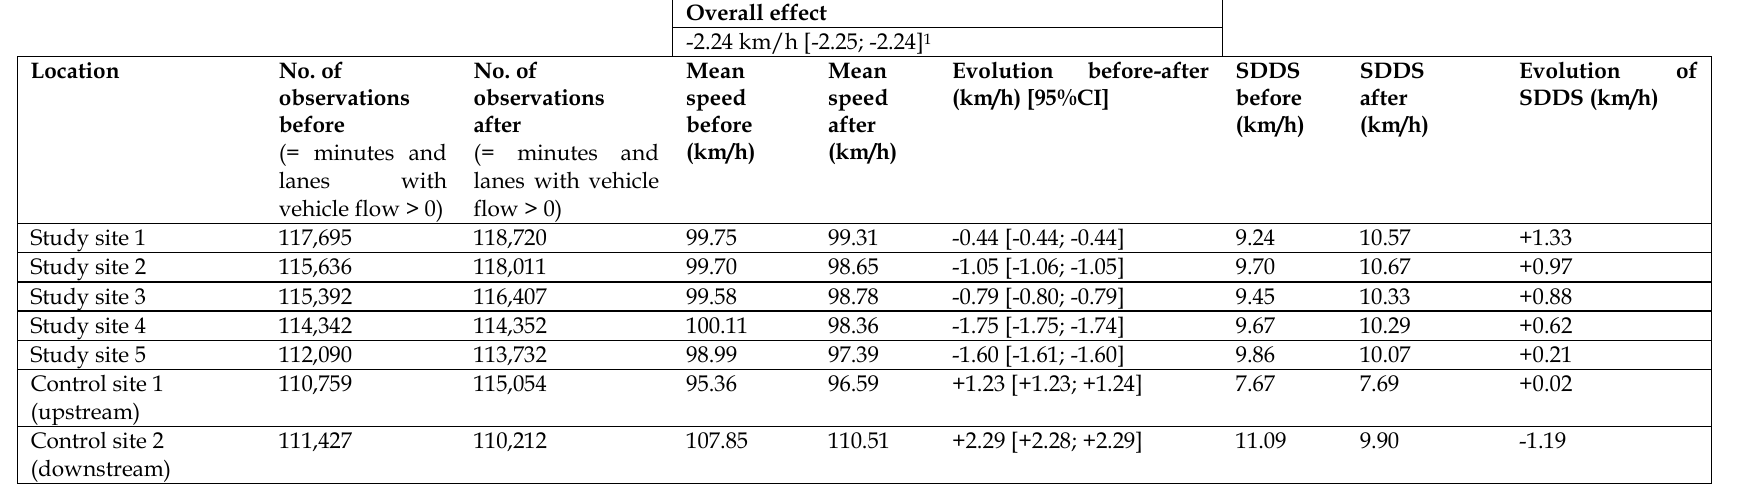
1 Parameter estimates for β 3 in Eq. 1 with 95%